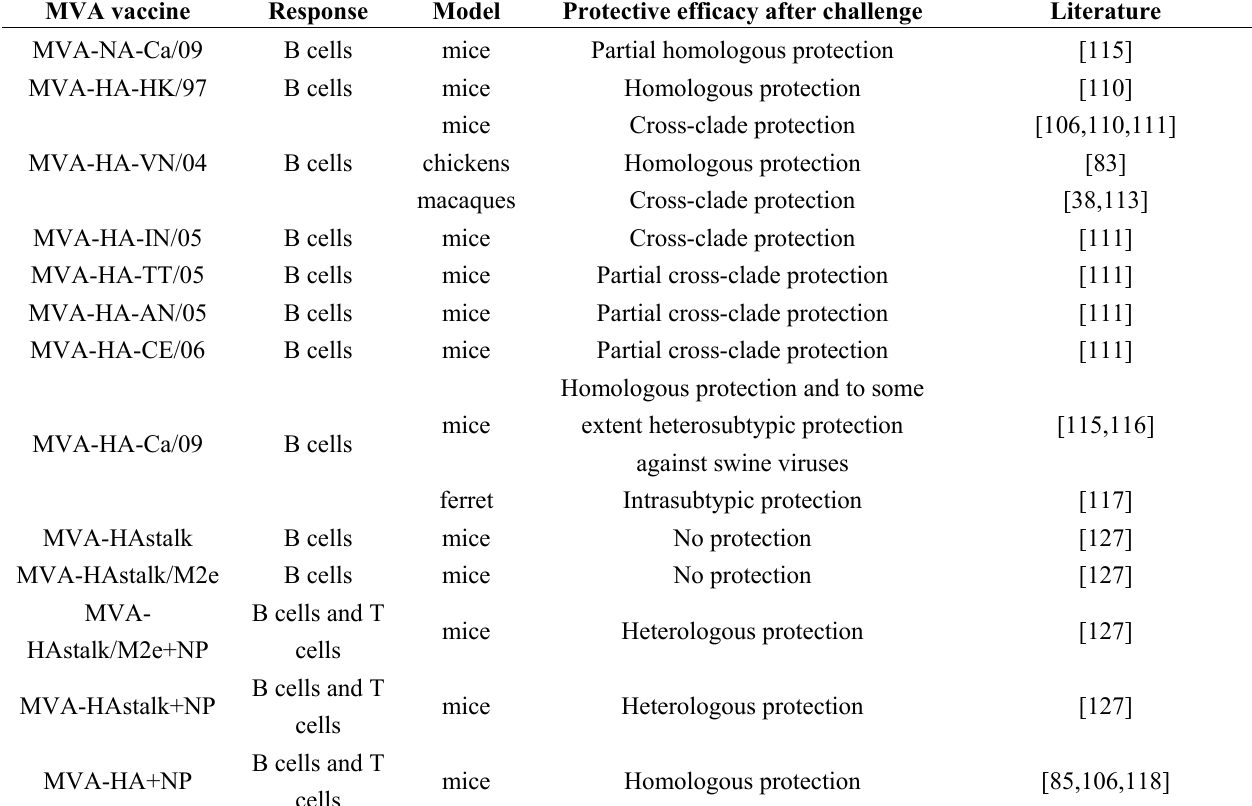
Table 1. Overview of MVA-based influenza